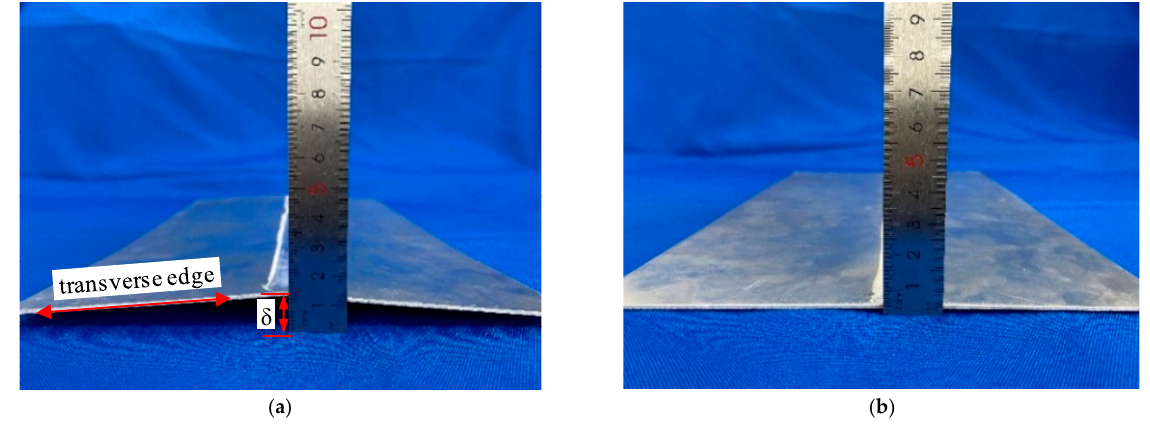
Figure 17. Deflection measurement results: ( a ) conventional welding; ( b ) welding with a trailing hybrid high-speed gas fluid field.